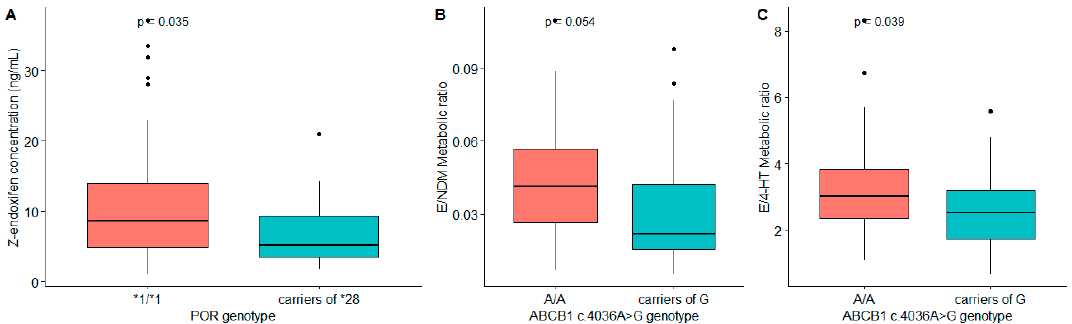
Figure 2. Plasma concentration of endoxifen and metabolic ratio (MR E/NDM ) by CYP2D6 diplotype ( A ) and phenotype ( B ).